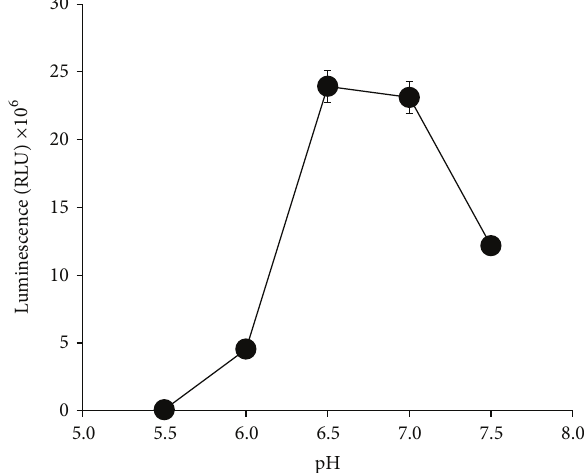
Figure7:EffectsofdifferentpHsonbioluminescenceproductionby Photobacterium sp. strain MIE in luminescence media. The isolate was grown in luminescence media at different pH and incubated in an orbital shaker (100rpm) for 12 hours at room temperature. Data is mean ± standard error of the mean ( 𝑛 = 3